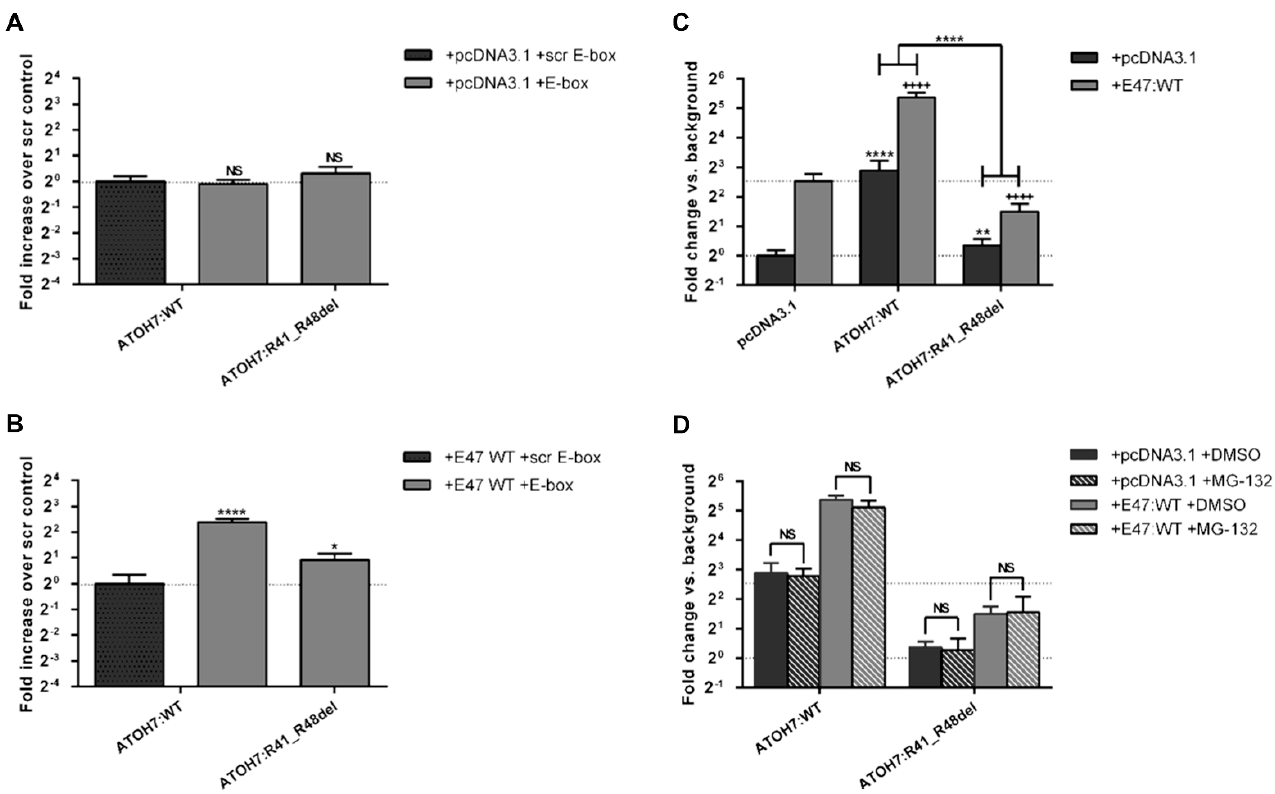
Figure 5. The mutant ATOH7:R41_R48del protein shows reduced DNA-binding, reduced transcriptional reporter activation and inhibition of the putative dimerization partner E47. ( A , B ) DNA-binding of ATOH7 was quantified through DNA-protein interaction ELISAs. V5-tagged ATOH7 from HEK293T cell lysate was mixed with lysate containing a dimerization partner consisting of either c-Myc-tagged ATOH7:WT ( A ) or c-Myc-tagged E47:WT ( B ) and was subsequently captured by biotin-streptavidin immobilized E-box DNA (7x CAGGTC). Results are normalized to background (sample without E-box DNA) and presented as fold-change relative to scr control (ATOH7:WT and scr E-box). Bars indicate mean of three independent experiments with three technical replicates ± SD. *, **, **** represent p -values of <0.05, <10 − 2 and <10 − 4 , respectively. ( C , D ) Transcriptional activation of ATOH7 quantified through dual luciferase assay. HEK293T cells were transfected with plasmid firefly luciferase gene expressed under the control of an E-box-containing minimal promoter, renilla luciferase under the control of a CMV-promoter and pcDNA3.1 constructs containing ATOH7 or E47 under the control of a CMV-promoter. Firefly luminescence of each sample was normalized to renilla luciferase luminescence and is presented relative to controls transfected with an empty pcDNA3.1 vector. ( C ) Comparison of transcriptional activation induced by ATOH7:WT and R41_R48del proteins in absence and presence of E47:WT. ( D ) Comparison of transcriptional activation with or without a four-hour pretreatment with the proteasomal inhibitor MG-132. Bars indicate the mean of three inde- pendent experiments with four biological replicates ± SD. Light grey bars represent luminescence in absence of E47:WT; black bars represent luminescence in presence of E47:WT. Asterisk symbols (*) represent significance vs. control without E47 expression; cross symbols (+) represent significance vs. control with E47:WT expression. The 1–4 significance symbols represent p -values of <0.05, <10 − 2 , <10 − 3 and <10 − 4 , respectively. ATOH7, atonal bHLH transcription factor 7; CMV, cytomegalovirus; E-box, enhancer box; E47, transcription factor 3 isoform E47; ELISA, enzyme-linked immunosorbent assay; HEK293T, human embryonic kidney 293T; NLS, nuclear localization signal; NS, not significant; scr, scrambled; SD, standard deviation; WT,